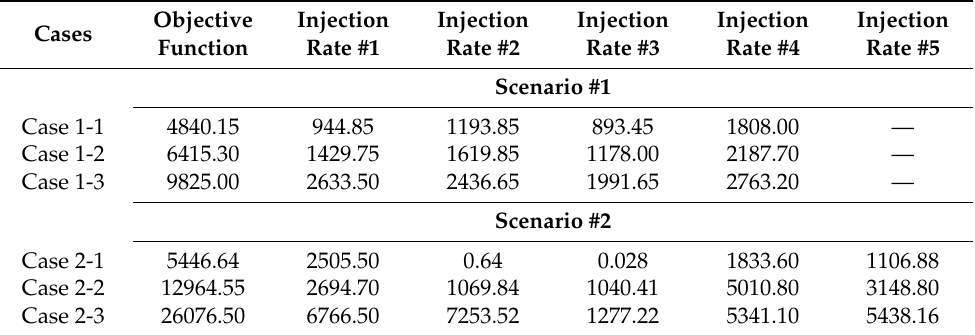
Table 5. The optimal results of management Scenarios #1 and